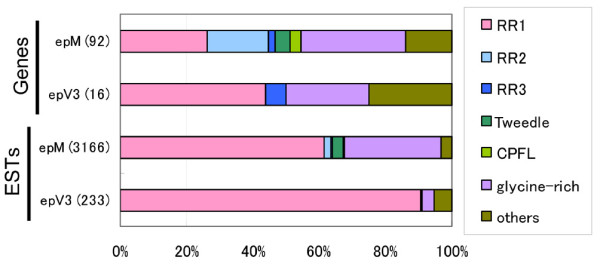
Composition of cuticular protein genes in two epidermal EST libraries (epM, epV3). The percentages of gene numbers (upper) and total clone numbers (lower) of each motif are shown. The numbers of gene numbers and total ESTs are shown in parentheses.